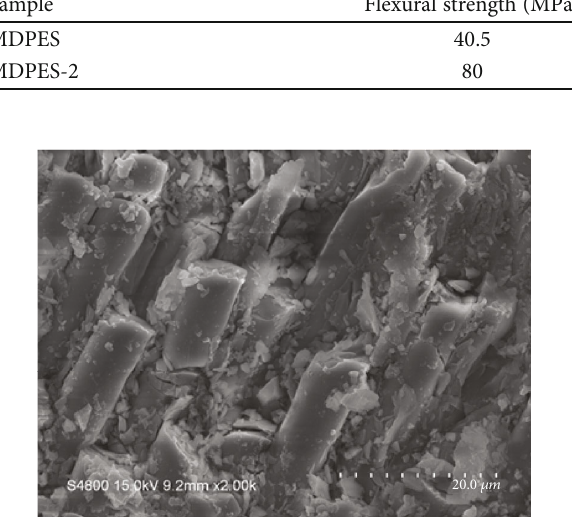
Figure 3: SEM of fractured surfaces of MDPES-2 composite ( × 2000).